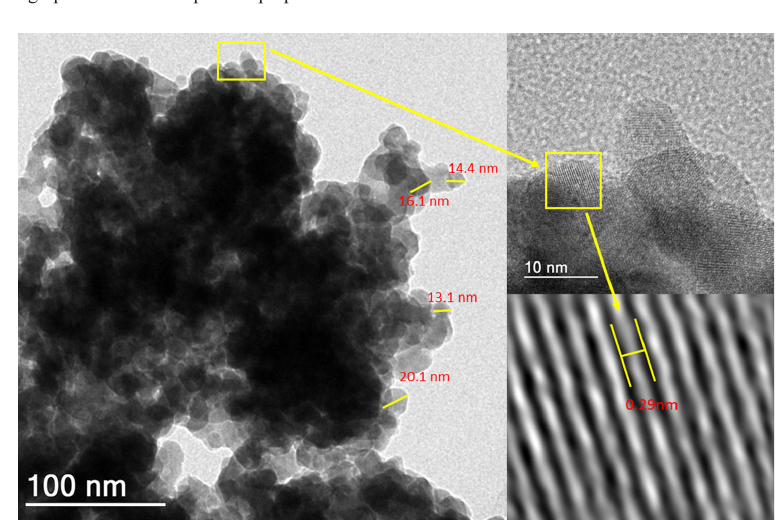
Figure 4. High-resolution transmission electron microscopy (HRTEM) images and the result of the treatment of the Fourier transform for